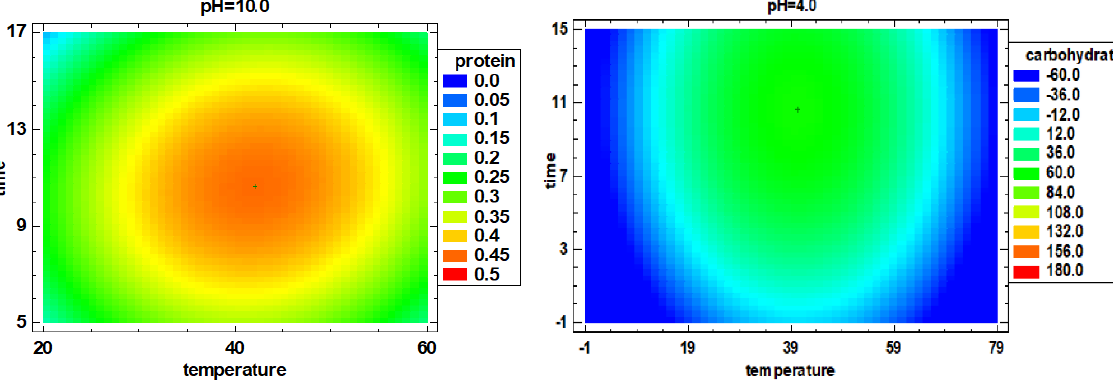
Figure 1. Estimated response surface of protein extract efficiency (%) and carbohydrate content (mg/g).